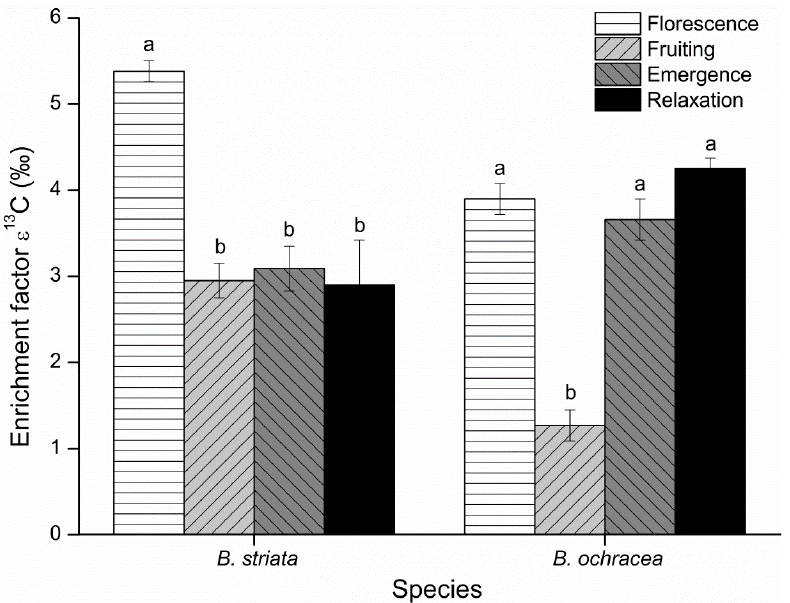
Figure 7. Enrichment factor ( ε ) for 13 C of Bletilla striata and B . ochracea collected at different phenological stages. Mean ε values of the autotrophic reference species are equal to zero. Different lowercase letters for each species indicate statistically significant differences among phenological stages ( p < 0.05).